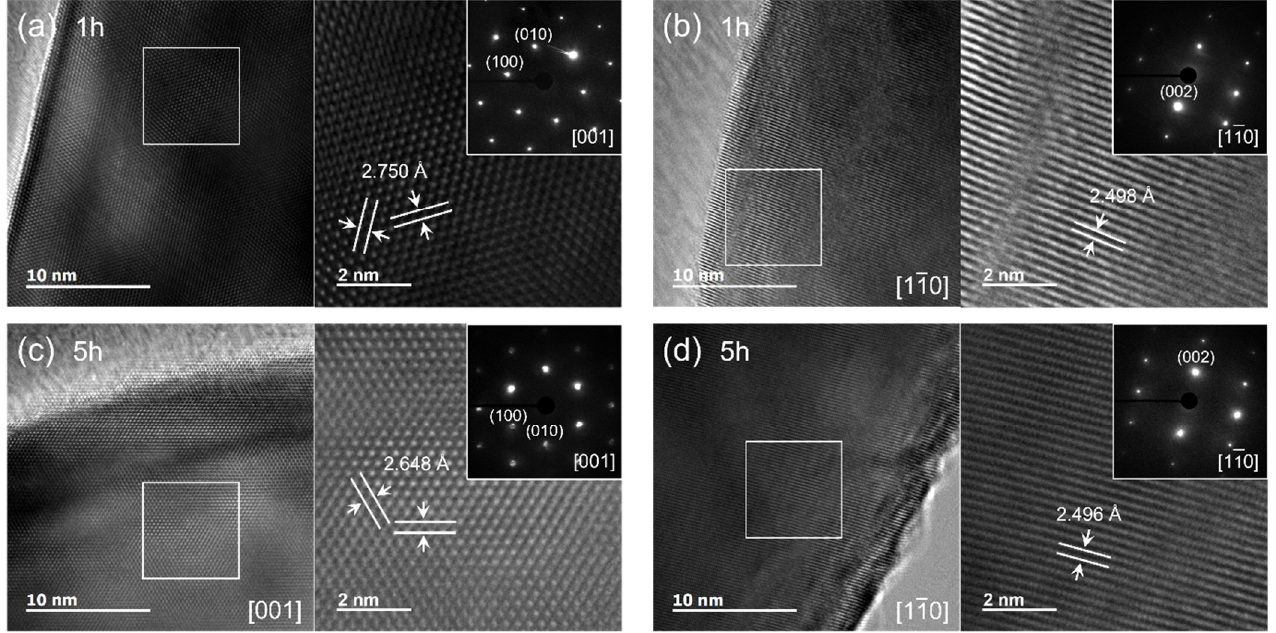
Figure 3. HRTEM images of 1 h ( a , b ) and 5 h ( c , d ) samples corresponding to the electron diffraction patterns shown as insets.